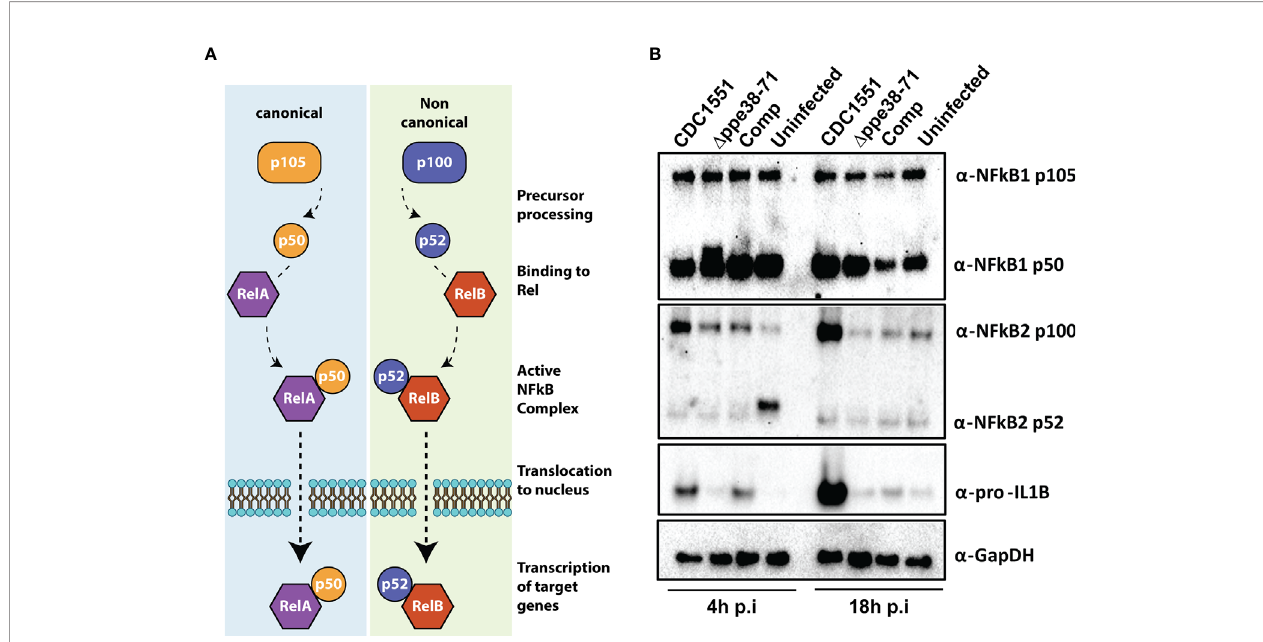
FIGURE 6 | THP-1 macrophage-like cells signal through the canonical NF-kB pathway when infected with M. tuberculosis CDC1551. (A) Schematic representation of the canonical and non-canonical NF-kB pathways. (B) Western blots for components of the NF-kB pathway ( a -NF-kB1 and a -NFkB2) and downstream effectors ( a -pro-IL1 b ) as well as their respective sub-units. The western blots were done on protein samples harvested at 4 hours and 18 hours post-infection. a -GapDH was used as a loading